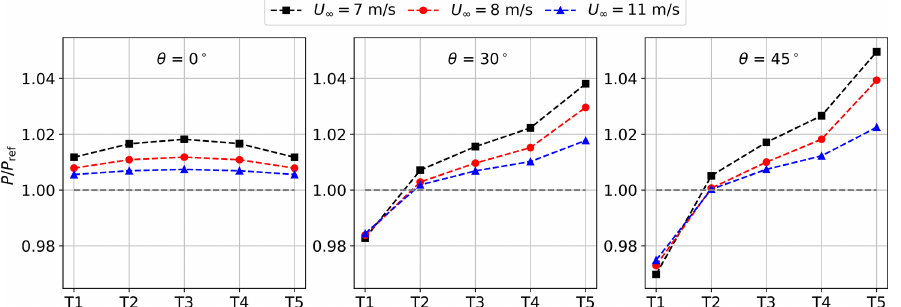
Figure 3. Power output of the five turbines normalised by that of an isolated turbine (placed at T3) for the cases with an inter-spacing of 2D predicted by